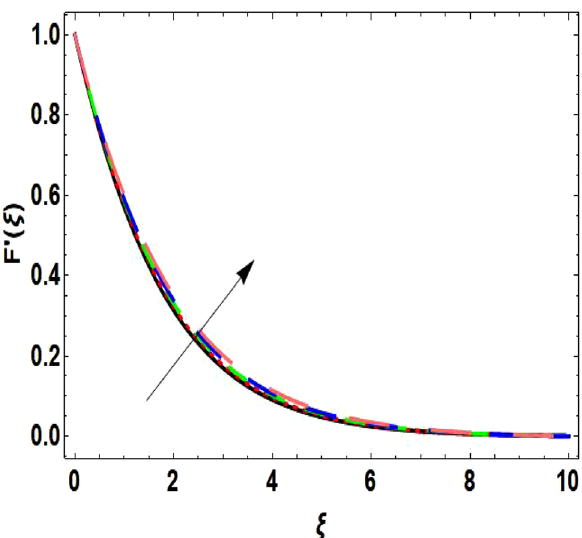
Figure 3. Velocity curve relative to exponential viscosity when A = 0.5, 2.5, 5.0, 7.0,